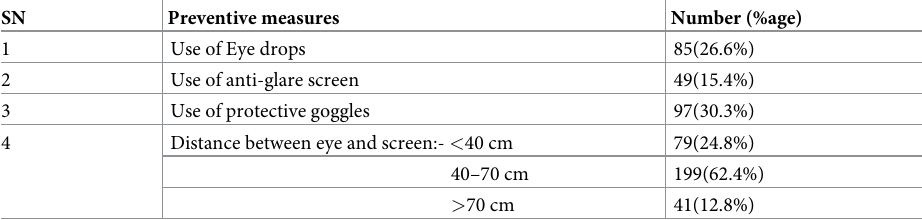
Table 3. Use of preventive measures in study participants.